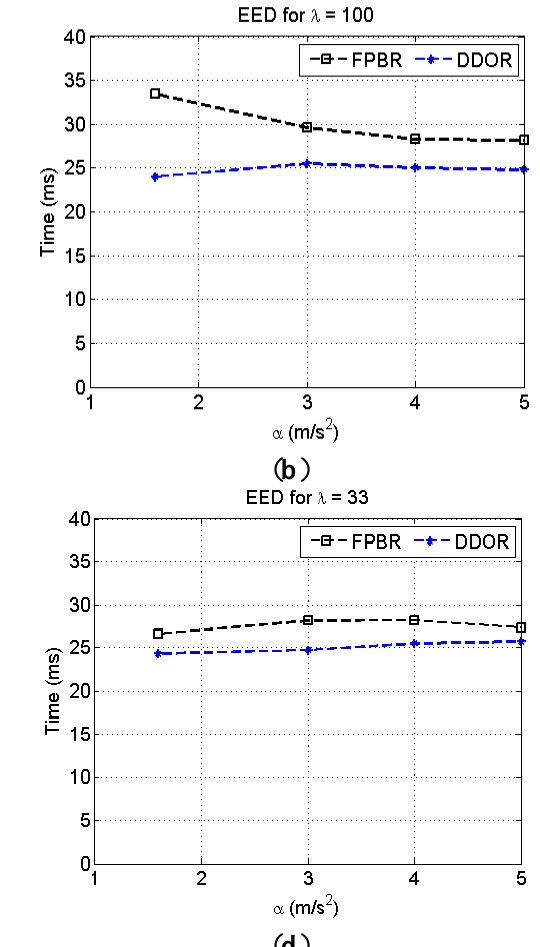
Figure 14. Average end-to-end delay (EED) obtained with FPBR and DDOR when increasing the maximum acceleration, . Four different vehicle densities, , were considered for these plots. Each plot shows the EED vs. α for: ( a ) λ = 133; ( b ) λ = 100; ( c ) λ = 66 and ( d ) λ =